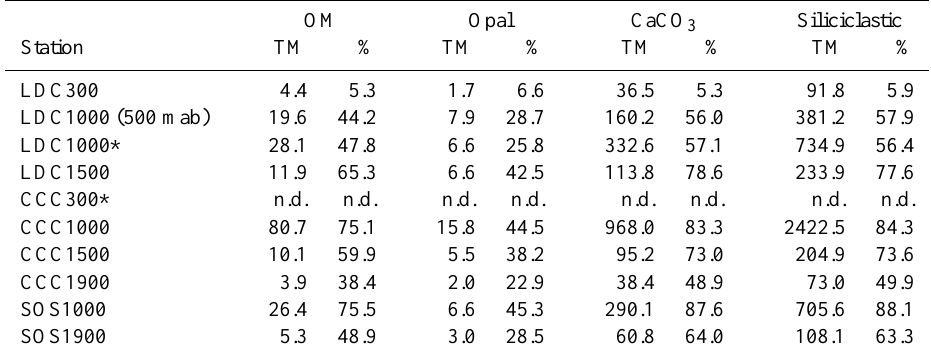
Table 3. Total Mass (TM) (gm − 2 ) settled of OM, Opal, CaCO 3 and Siliciclastic during the main DSWC period and percentage that represents respect the total experiment period. ∗ Data gaps, see Fig. 3. OM